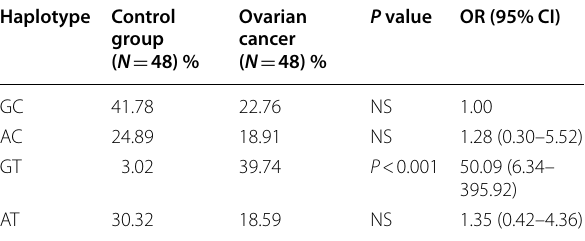
Table 3 Haplotype frequencies of the IL‑10 ( polymorphisms in healthy individuals and patients with